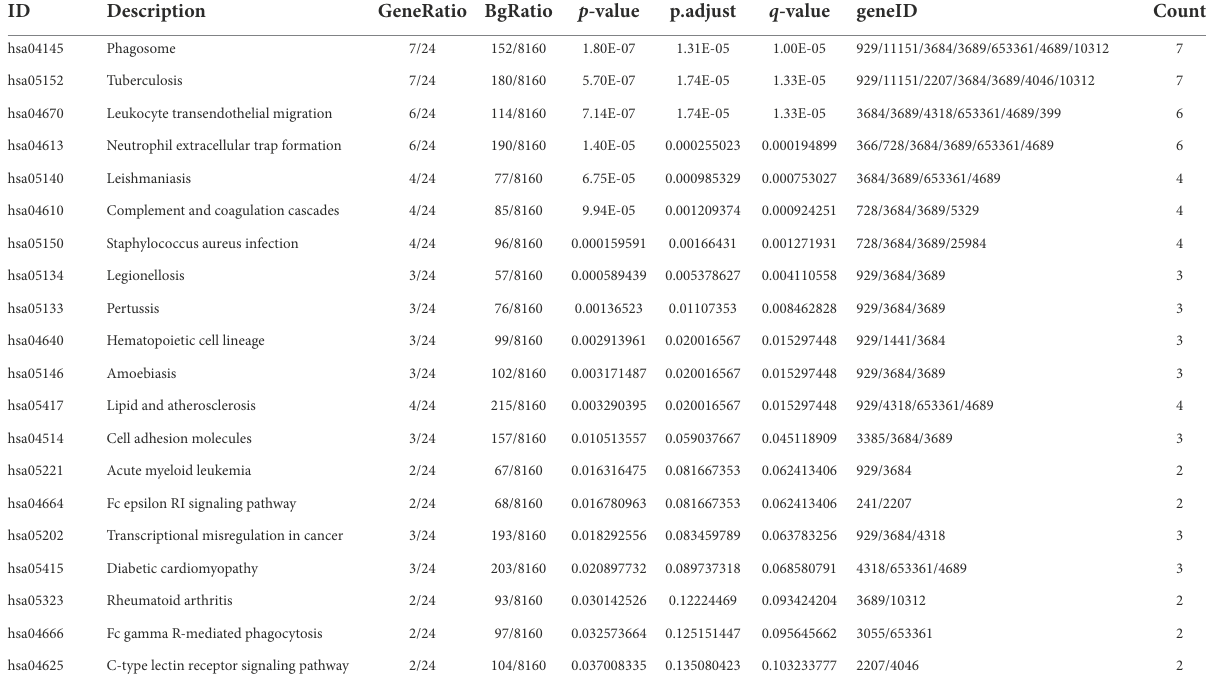
TABLE 4 The top 20 signaling pathways enriched by the crosstalk